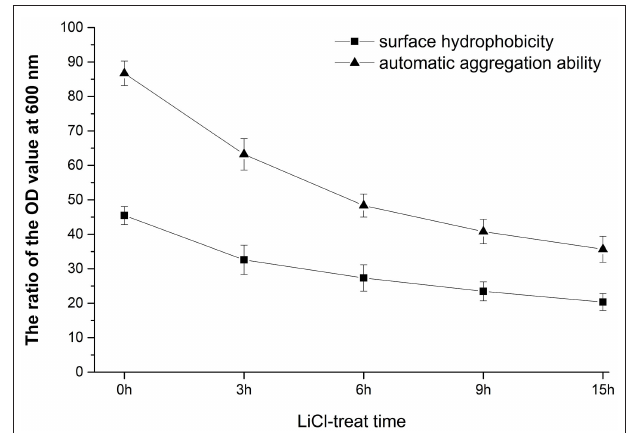
FIGURE 1 | Analysis of surface properties of HC-2 strain. After being treated with lithium chloride (LiCl) at different times, the automatic aggregation ability and surface hydrophobicity rate were